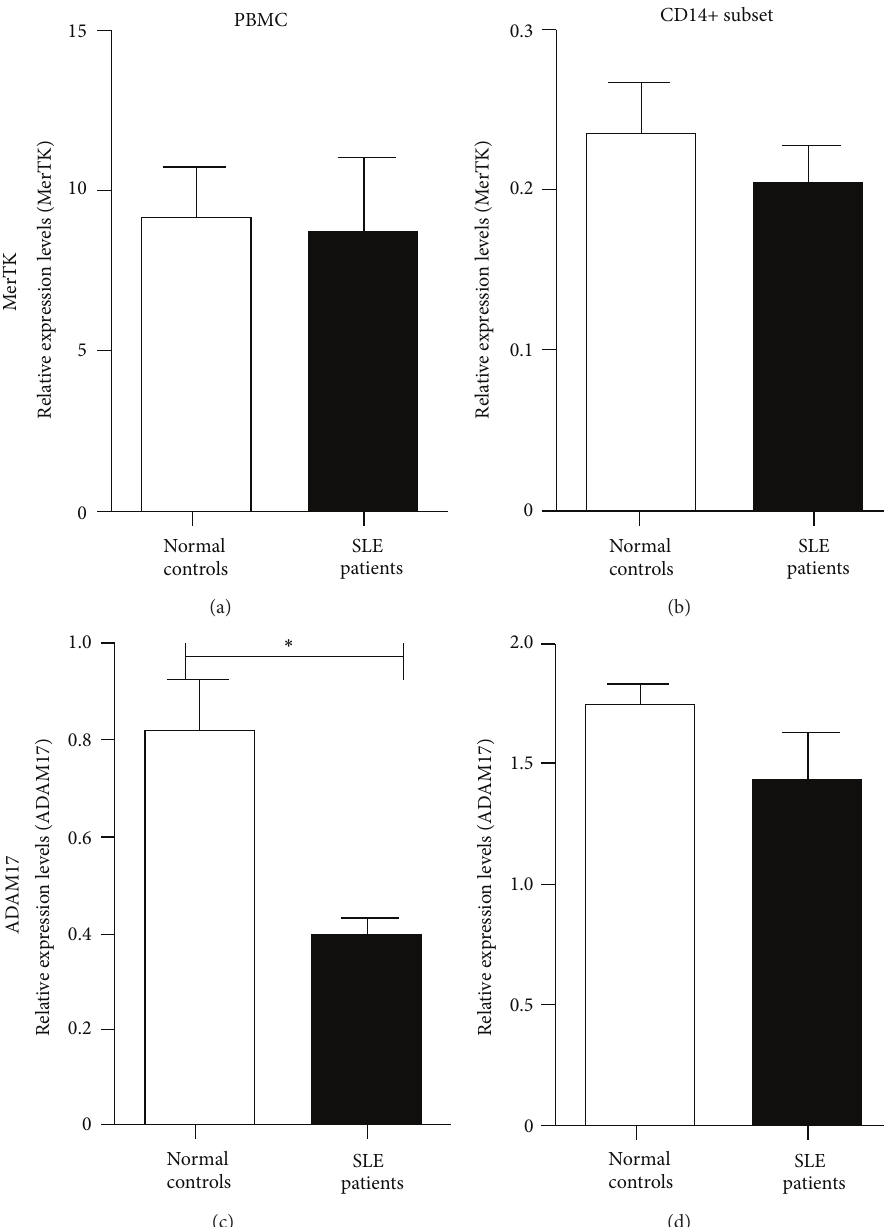
Figure 1: Comparison of gene expressions in PBMC (26 healthy controls and 35 SLE patients for MerTK; 6 healthy controls and 6 SLE patients for ADAM17) and CD14+ monocytes/macrophages. Relative MerTK expression levels in PBMC and CD14+ are shown in (a) and (b), respectively. (c) and (d), respectively, demonstrated the ADAM17 expression in PBMC and CD14+ monocytes/macrophages. Histograms in solid show the relative gene expression in SLE patients compared with expression in healthy controls (histogram in blank). Vertical lines out histograms show standard errors. PBMC: peripheral blood mononuclear cell; MerTK: Mer tyrosine kinase; ADAM17: A Disintegrin And Metalloproteinases domain 17. ∗ 𝑃 < 0.05